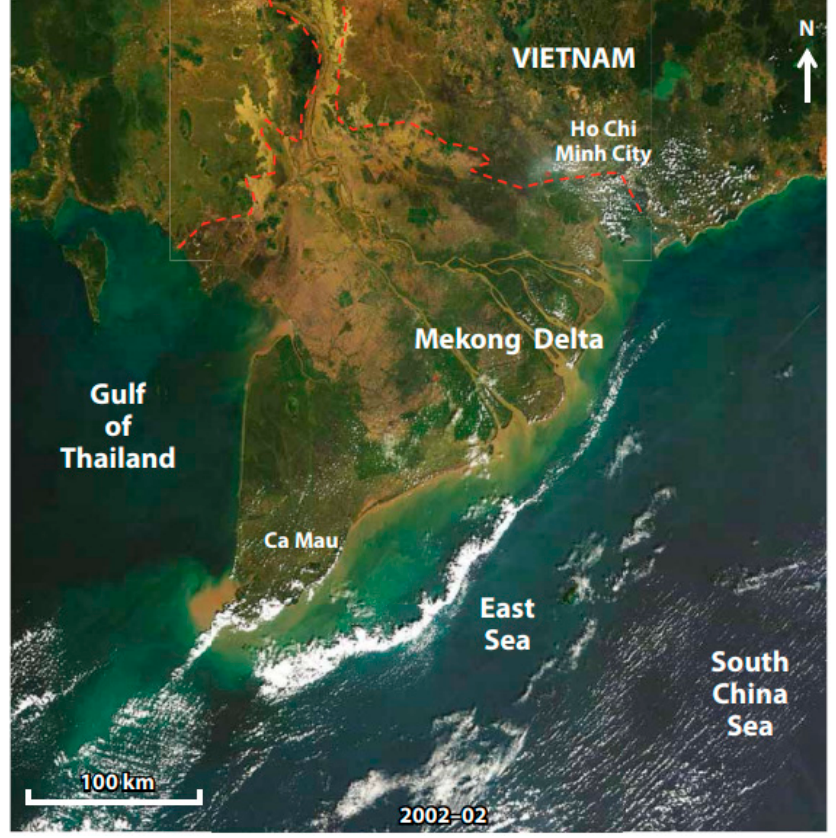
Figure 3. The Mekong River subaqueous delta [22].